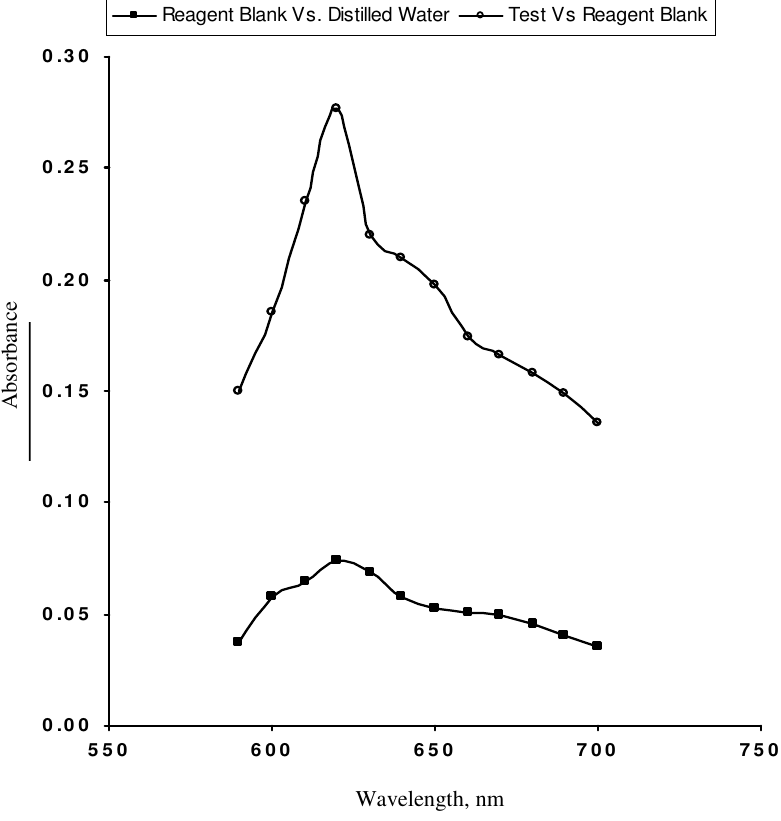
Figure 2. Absorption spectrum of FXA –